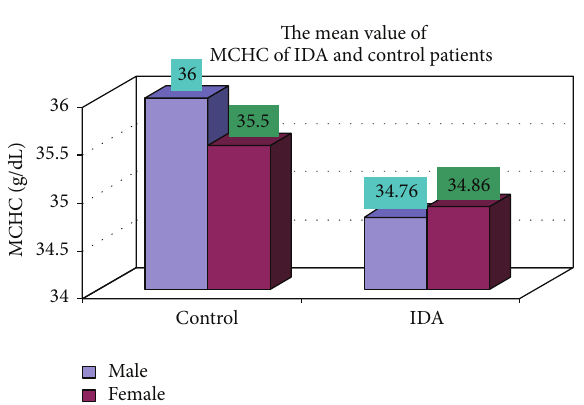
Figure 11: Showing the mean value RDW of control and iron deficiency anemia.